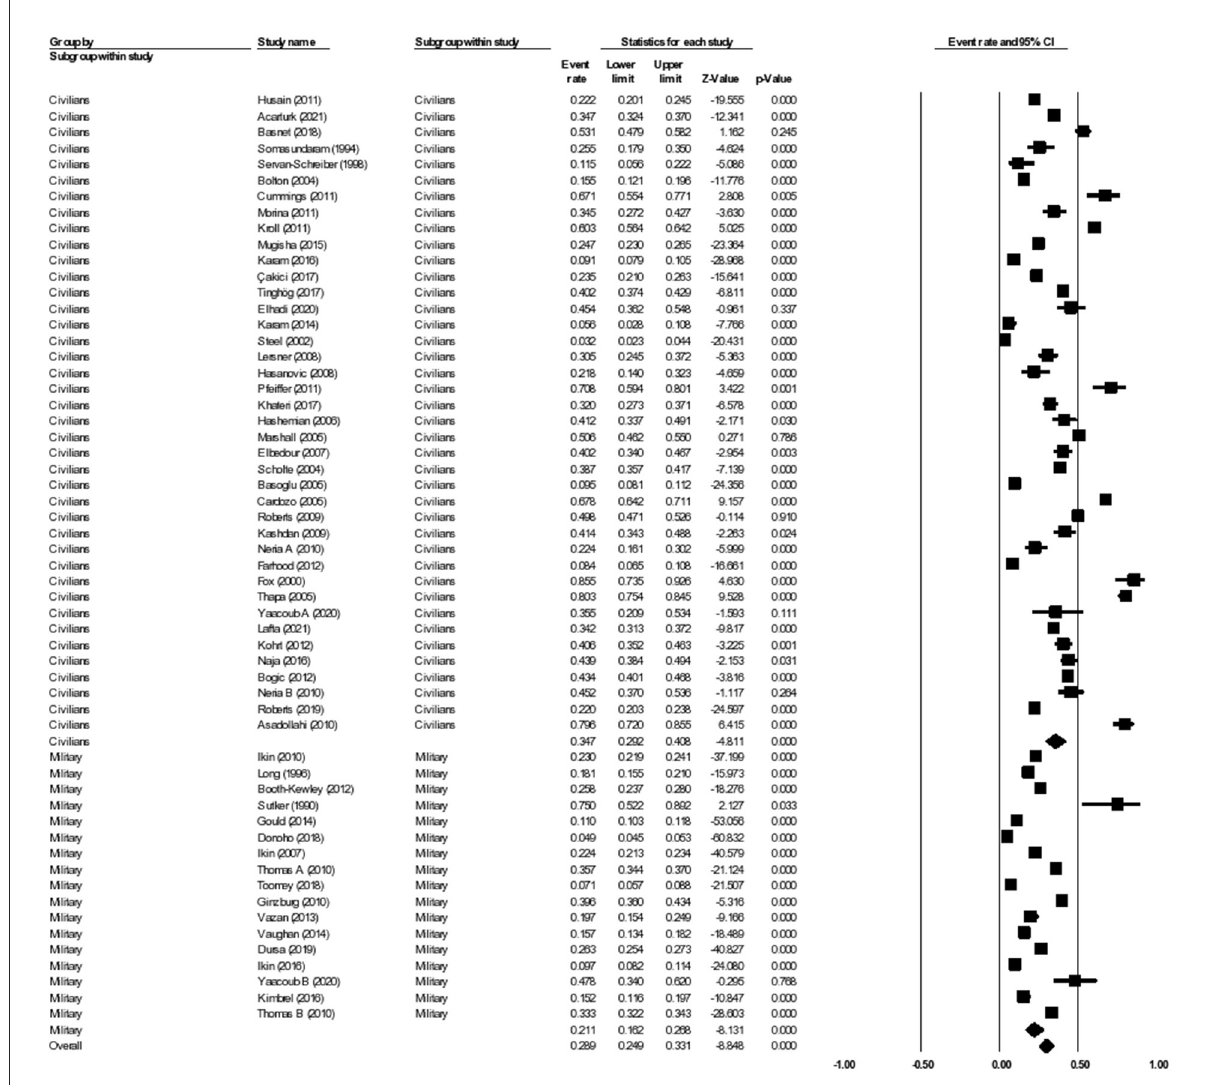
FIGURE2 Forest plot showing prevalence of depression, including analysis between military and civilian subgroups.